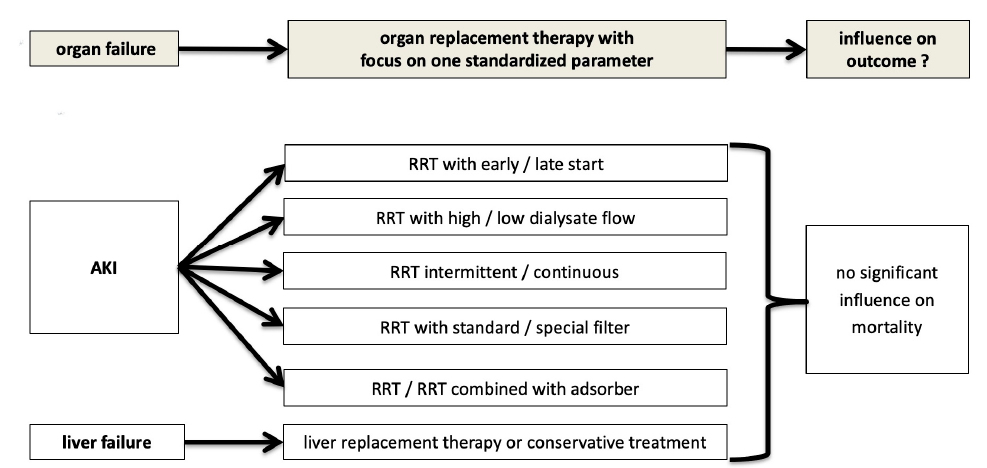
Figure 2. Classic approach in large studies on AKI and RRT in critically ill patients: selecting a single variable as target.